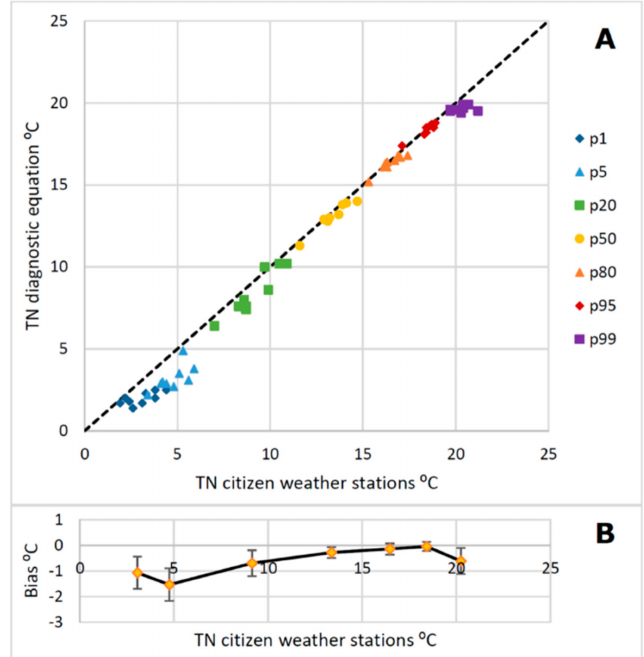
Figure 5. ( A ) Quantile–quantile plot for modeled and observed (Davis and Oregon citizen weather stations) night-time minimum temperatures for the years 2015–2016. ( B ) The bias between the data from these citizen weather stations and the diagnostic equation are presented as a function of temperature. Error bars indicate the standard